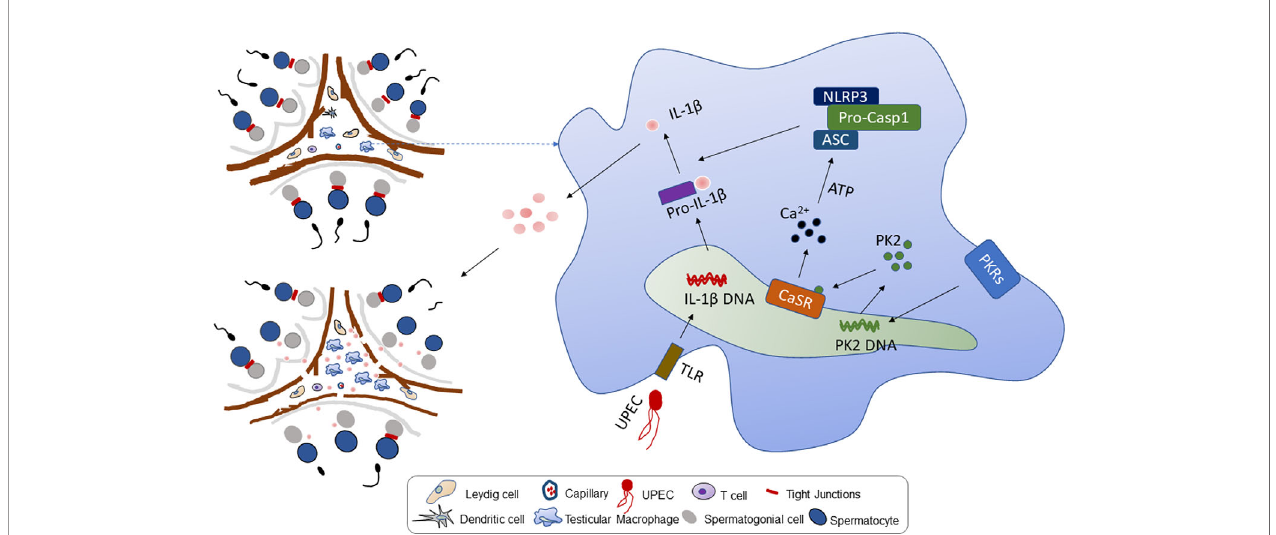
FIGURE 6 | Working model of UPEC-induced Prokineticin 2 via CaSR activated NLRP3 in fl ammasome in TM. Upper left: The model diagram of rat testis structure, including two parts of spermatogenic tubule and testicular interstitium. Right: After UPEC infection, NLRP3 in fl ammatory bodies in rat TM are activated to secrete a large amount of proin fl ammatory factor IL-1 b . In the process, UPEC infection induces large amounts of PK2 secreted into the cytoplasm to stimulate the activation of CaSR, and activates the NLRP3 in fl ammasome by increasing the level of calcium ions in the cytoplasm of macrophages. Bottom left: The large amount of proin fl ammatory factor IL-1 b secretion leads to a decrease in testosterone levels, and the normal physiological structure of testicular tissue is